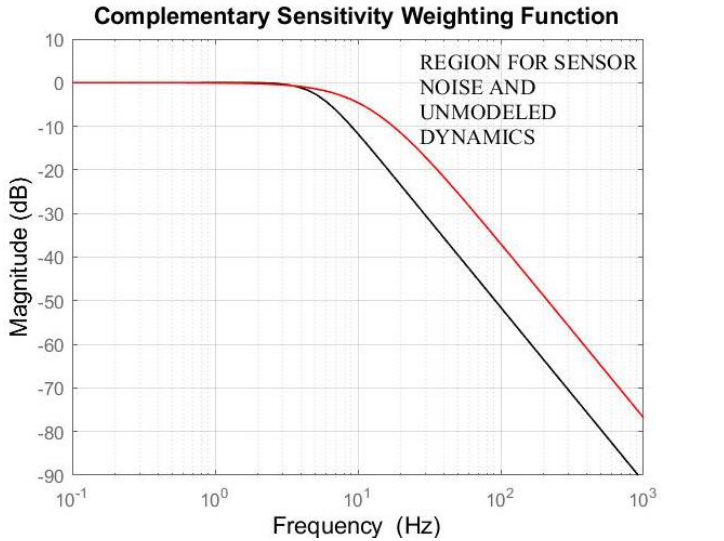
Figure 5. W T ( s ) Weighting Function—Black line: Complementary Sensitivity function; Red line: Weighting